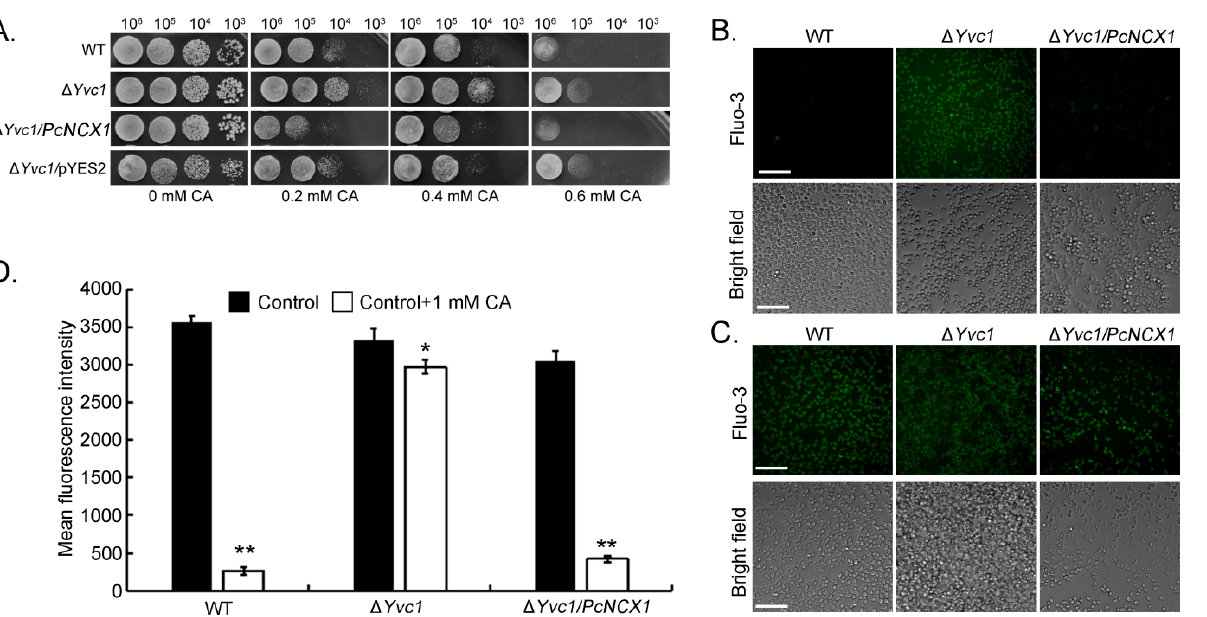
Figure 3. The PcNCX1 gene rescued the CA sensitivity of yeast Δ Yvc1 mutant. ( A ) The yeast Δ Yvc1 mutant was transformed with the pYES2 ‐ PcNCX1 construct expressing PcNCX1. The wild type strain was also transformed with the empty pYES2 vector as a control. Serial dilutions of cultures of all strains were grown overnight on SD ‐ Met ‐ Leu ‐ His (Synthetic dropout medium lacking of methionine, leucine, and histidine) (glucose) or SD ‐ Met ‐ Leu ‐ His (glucose + 0.2/0.4/0.6 mM CA) plates, and grown at 30 °C for 4 days and photographed. The complementary transformant restores the immediate Ca 2+ efflux of the yeast Δ Yvc1 mutant treated with ( B ) and without ( C ) CA. ( D ) The mean fluorescence intensity of the wild type, the Δ Yvc1 mutant and the complementary transformant Δ Yvc1/NCX1 treated with 1 mM CA. The experiment was repeated at least three times, and representative results were photographed. Asterisk indicates statistically significant differences (*, p < 0.05; **, p < 0.01), Bar = 30 μ m.